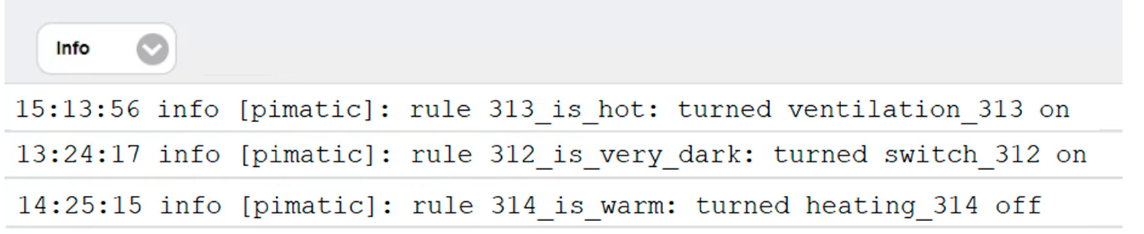
Figure 10. Examples explaining system behavior.